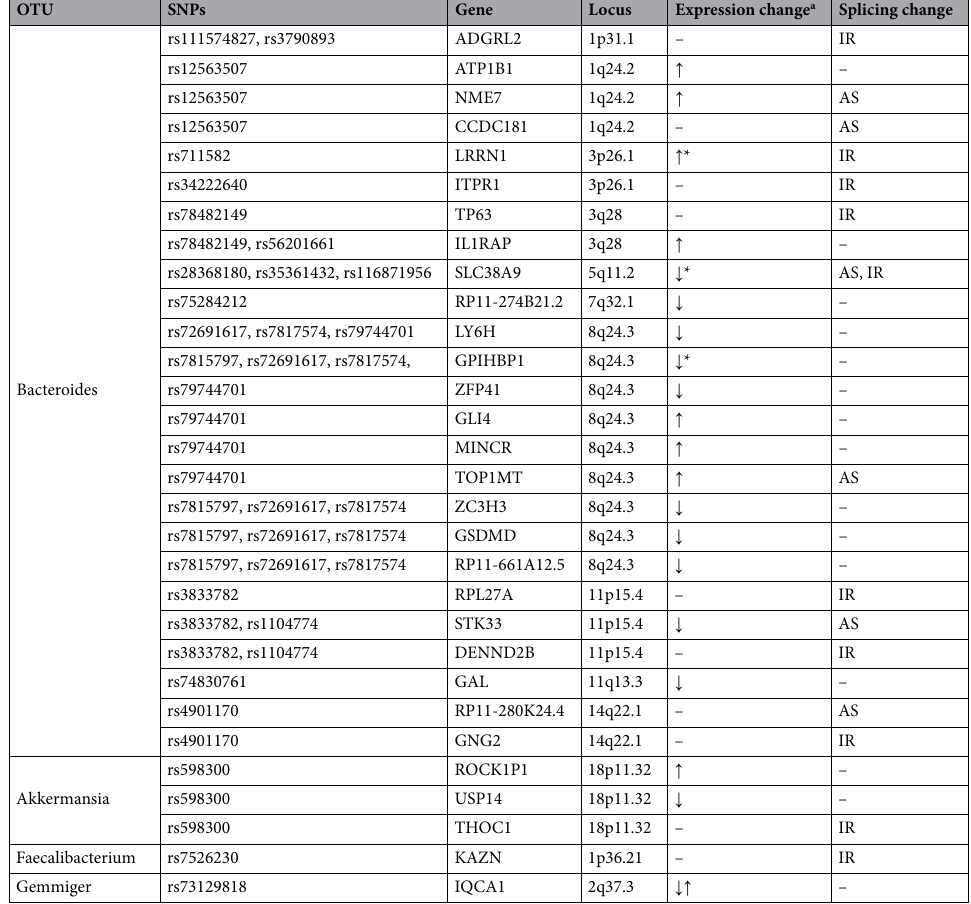
Table 3. Genetic regulatory effects of operational taxonomic unit (OTU)-specific mbQTLs. a Upregulation ( ↑ ) or downregulation ( ↓ ) in the colon (*) or other tissues, associated with an increasing frequency of minor alleles (GTEx database; FDR < 0.05). ↓↑ Divergent results in two tissues; –, no change reported. AS,